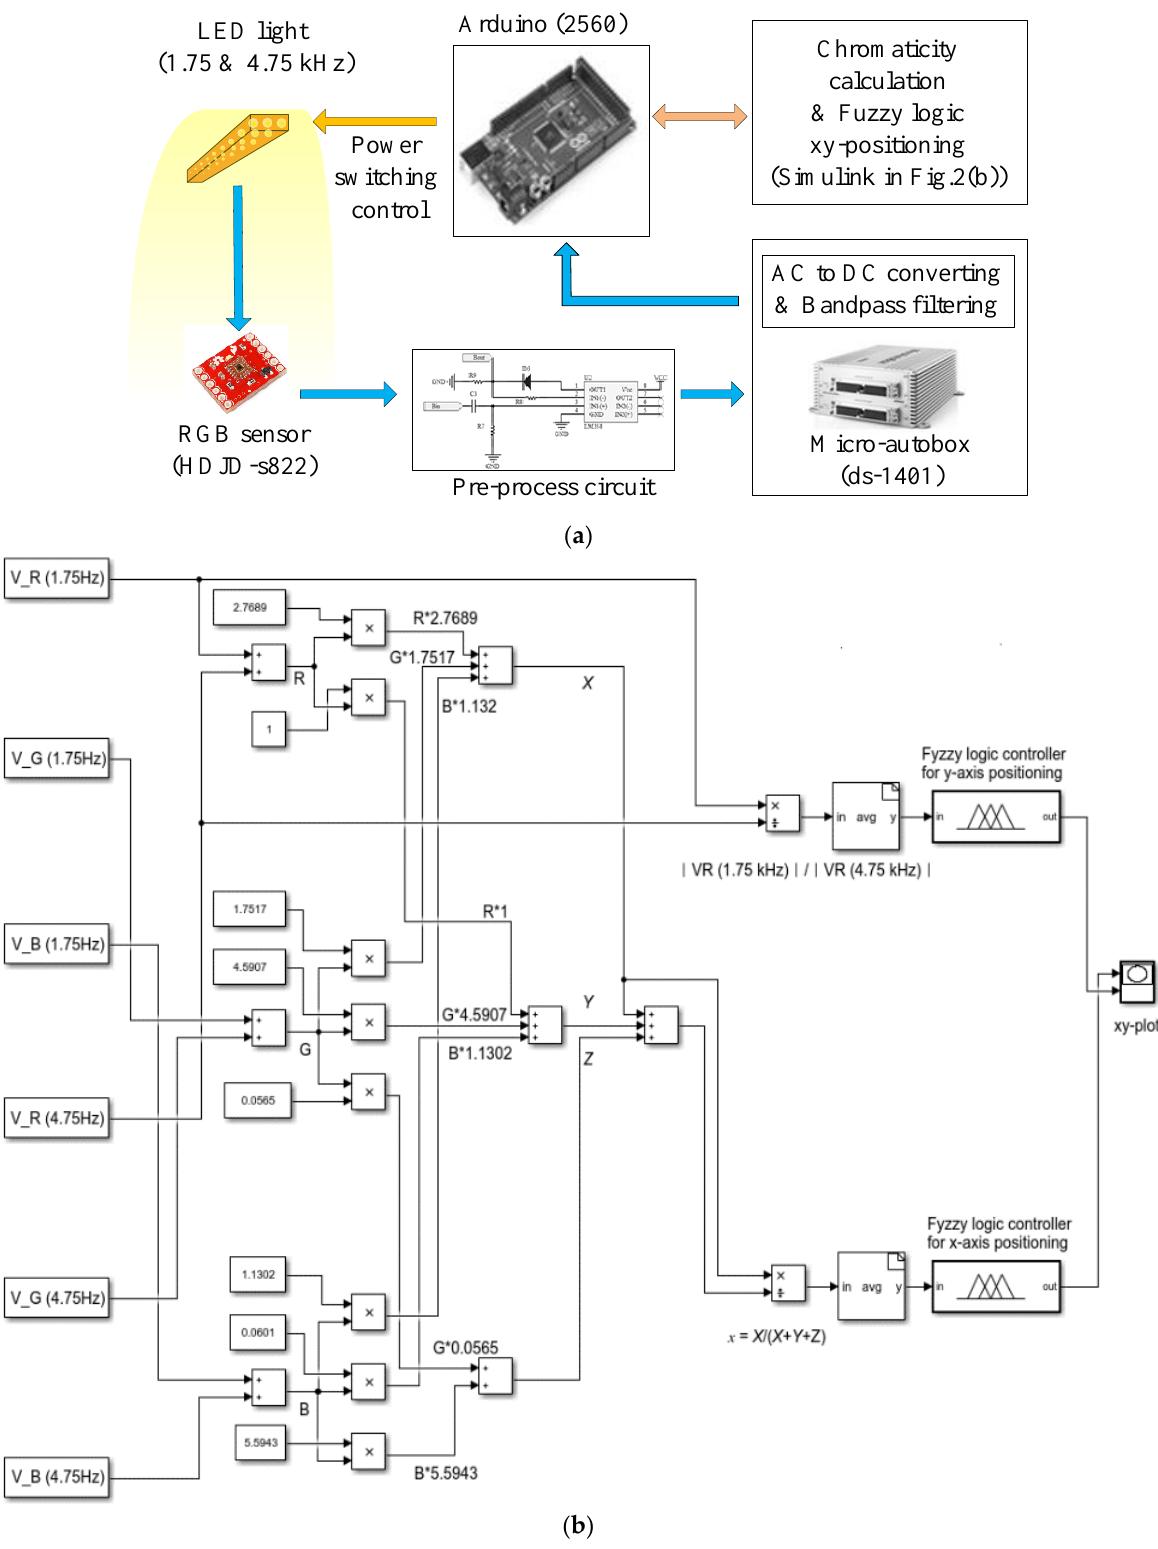
Figure 2. Signal-processing workflow: ( a ) Schematic of signal-processing procedure; ( b ) Simulink model for fuzzy positioning.